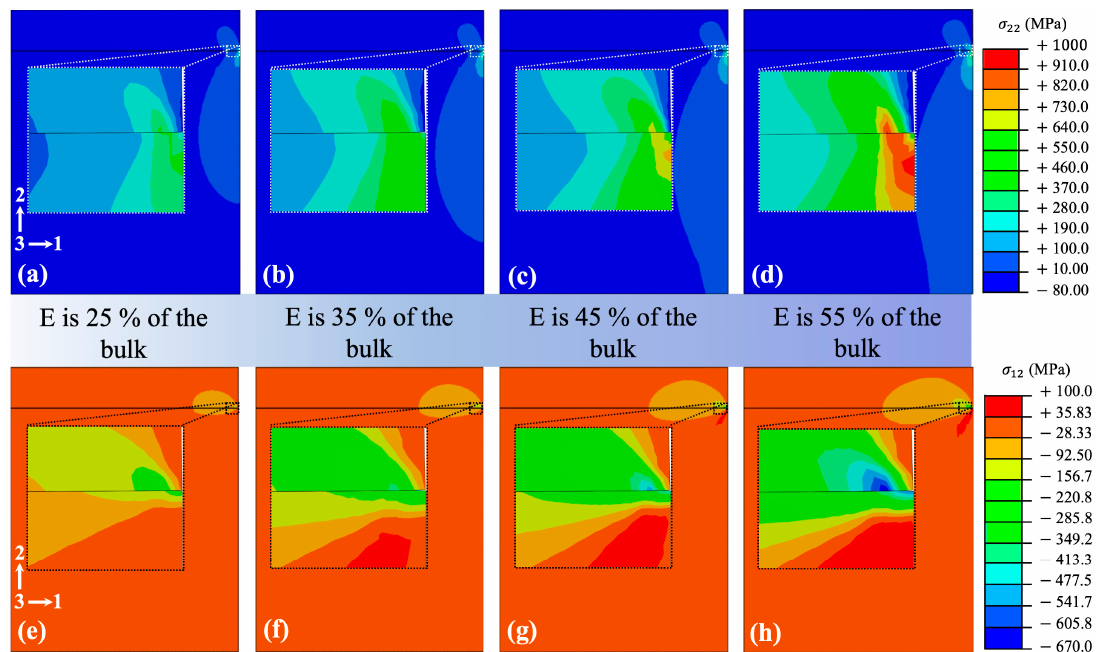
Figure 12. Effect of TC elastic modulus on the stress distribution, tensile stress E is ( a ) 25%, ( b ) 35%, ( c ) 45%, ( d ) 55% of the bulk; and shear stress E is ( e ) 25%, ( f ) 35%, ( g ) 45%, ( h ) 55% of the bulk, the arrows mean the coordinate system.